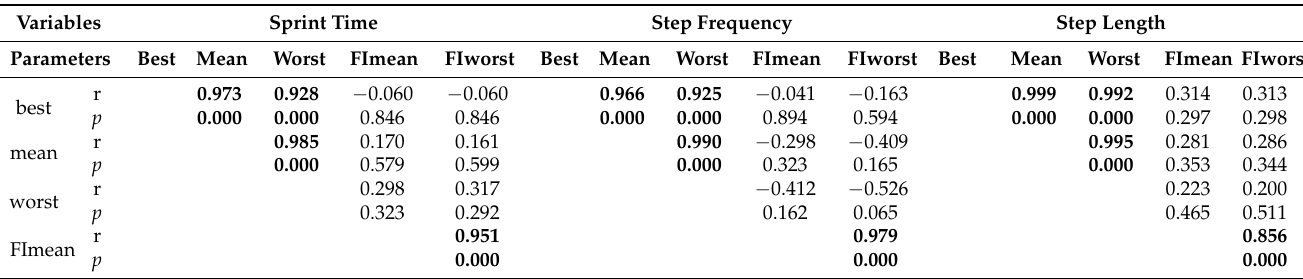
Table 2. Relationships between the best, mean, worst, FImean, and FIworst parameters within the step kinematics (sprint time, step frequency, and step length) during the RSA test in elite female field hockey players. Bold: Different from the first repetition at p < 0.05. Variables Sprint Time Step Frequency Step Length Step